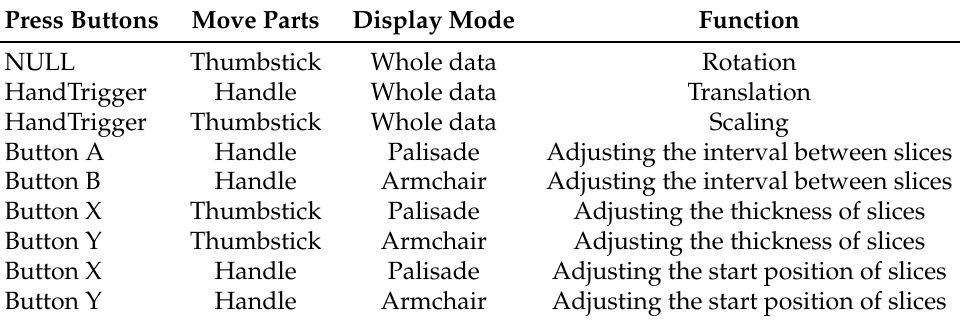
Figure 4. The transfer function editor consists of an adjustment view ( left ) and a preview view ( right ). In the adjustment view, the user can modify the color and opacity corresponding to a certain range of intensity values, and preview the real-time rendering result on the immersive device. Table 1. The design of Touch Handle interaction in an immersive